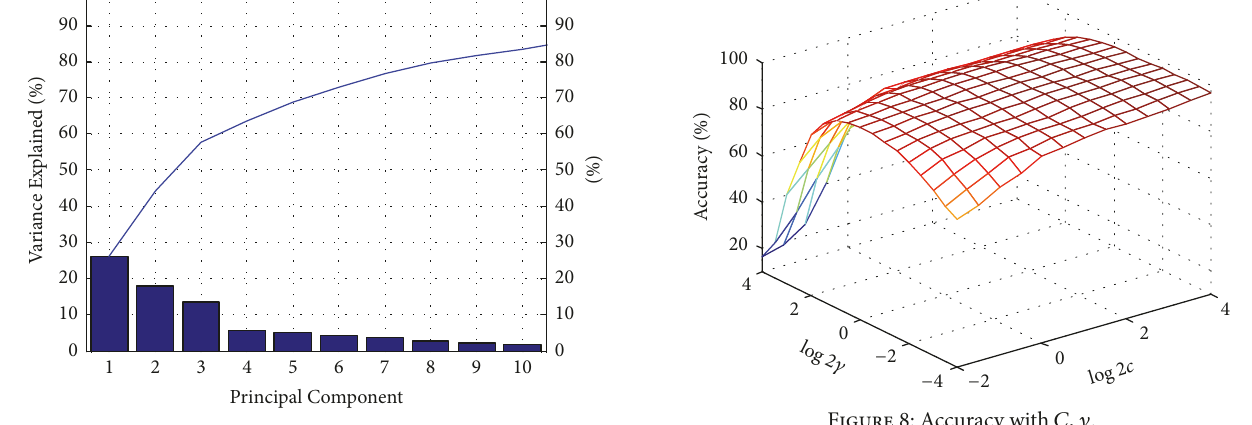
function, first use the cross-validation (CV) method to get regularization parameter (𝐶) and kernel parameter (𝛾) , both of the search range [10 −2 10 2 ] ; the index step is 0.5, the relationship of the trained MSVM accuracy and 𝐶 , 𝛾 is shown in Figures 8 and 9.